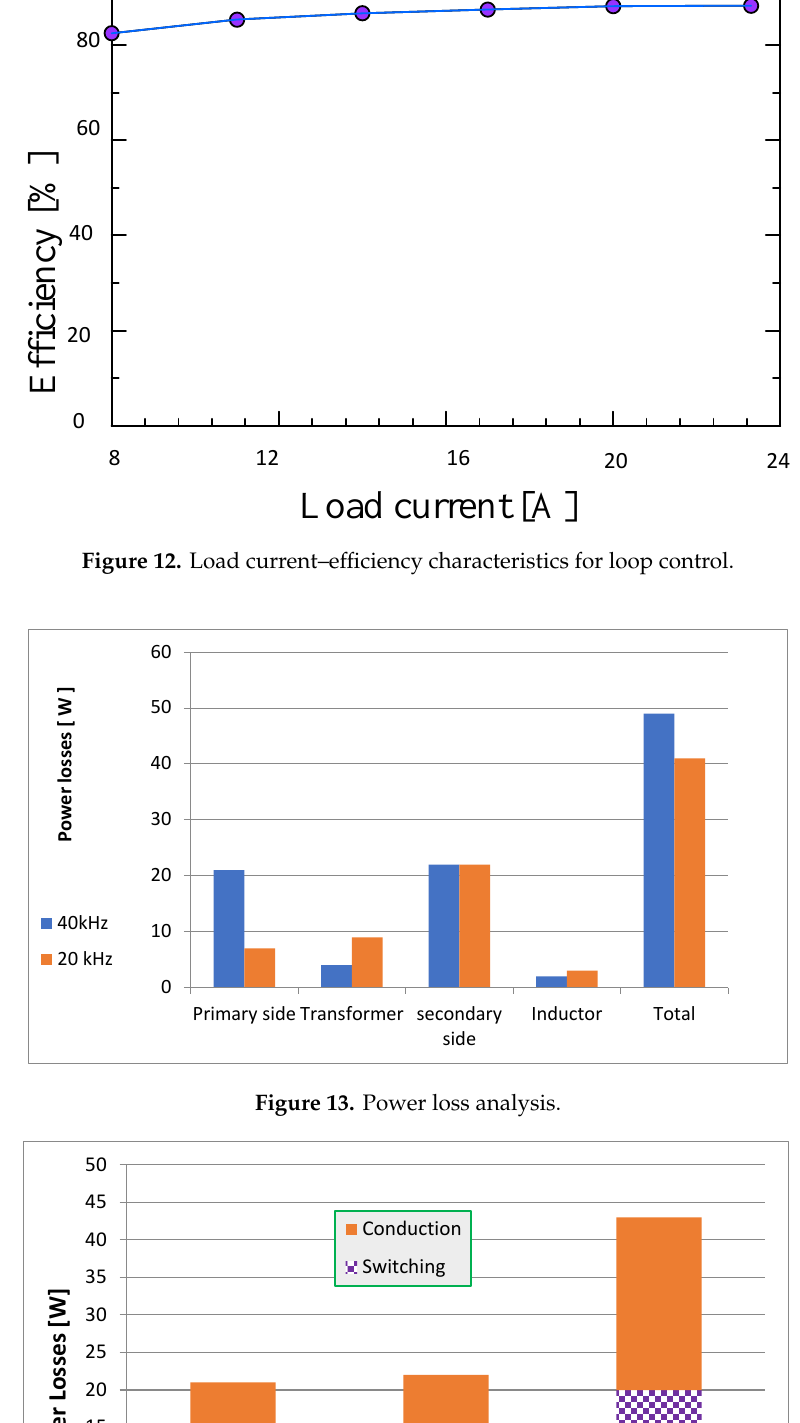
Figure 12. Load current–efficiency characteristics for loop control.